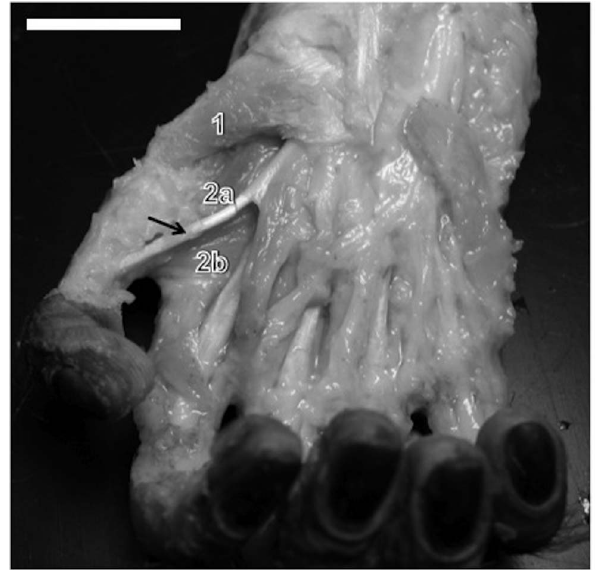
Figure 2. A capuchin right hand. Dissection shows (arrow) the tendon of insertion of digit I long flexor muscle, (1) opponent muscle, and adductor muscle’s (2a) oblique head and (2b) transverse head. (bar=2.8